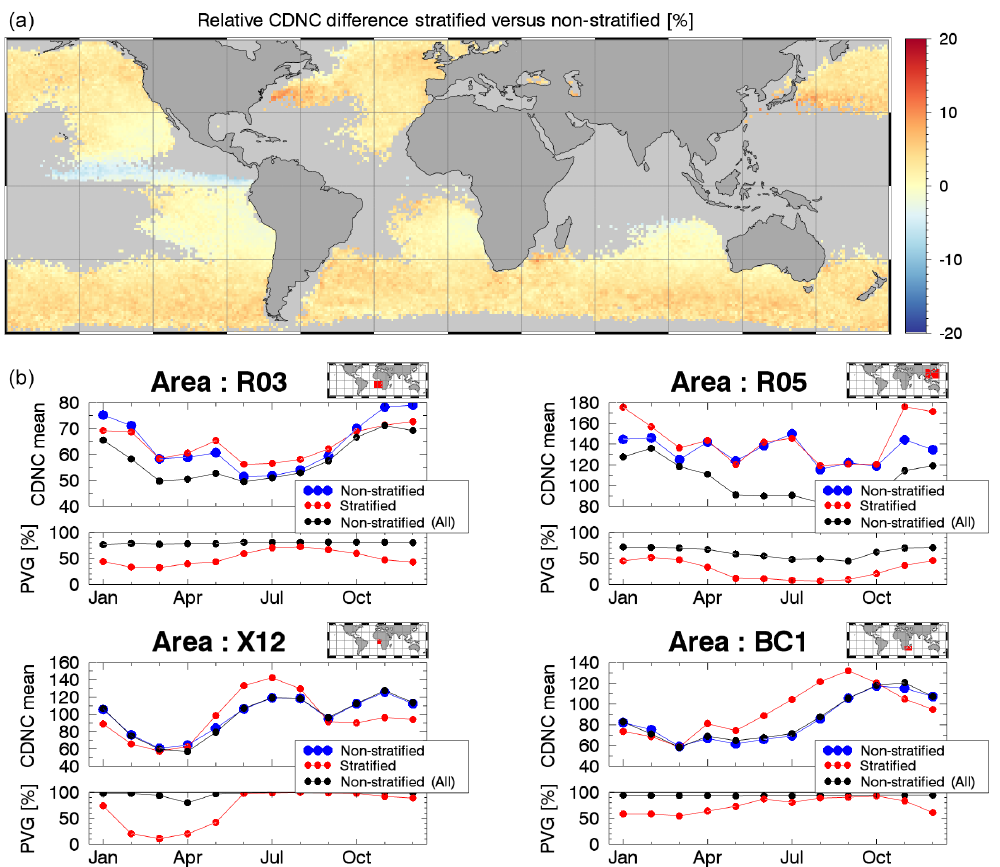
Figure 5. Comparison of results for 2008 for “Stratified” versus “Non-stratified” climatologies. See Table 1 for terminology. Panel (a) shows the relative difference in 2008 mean CDNC between “stratified” and “non-stratified”. Panel (b) shows the annual cycle of CDNC for four selected regions where differences between “stratified” and “non-stratified” were particularly strong. The figures also show the “percentage of valid grid points”, labelled “PVG”. PVG corresponds to the number of (1 × 1 ◦ ) grid points in a region that have valid CDNC estimates, divided by the total number of grid points in that region times 100. The three different annual cycles in CDNC correspond to region-wide averages over all grid boxes with valid “non-stratified” CDNC estimates (black); averages over all grid boxes with valid “stratified” CDNC estimates (red); and averages of non-stratified estimates only over those grid boxes where “stratified” CDNC estimates are also available (blue). For details on the selected regions, see also Table